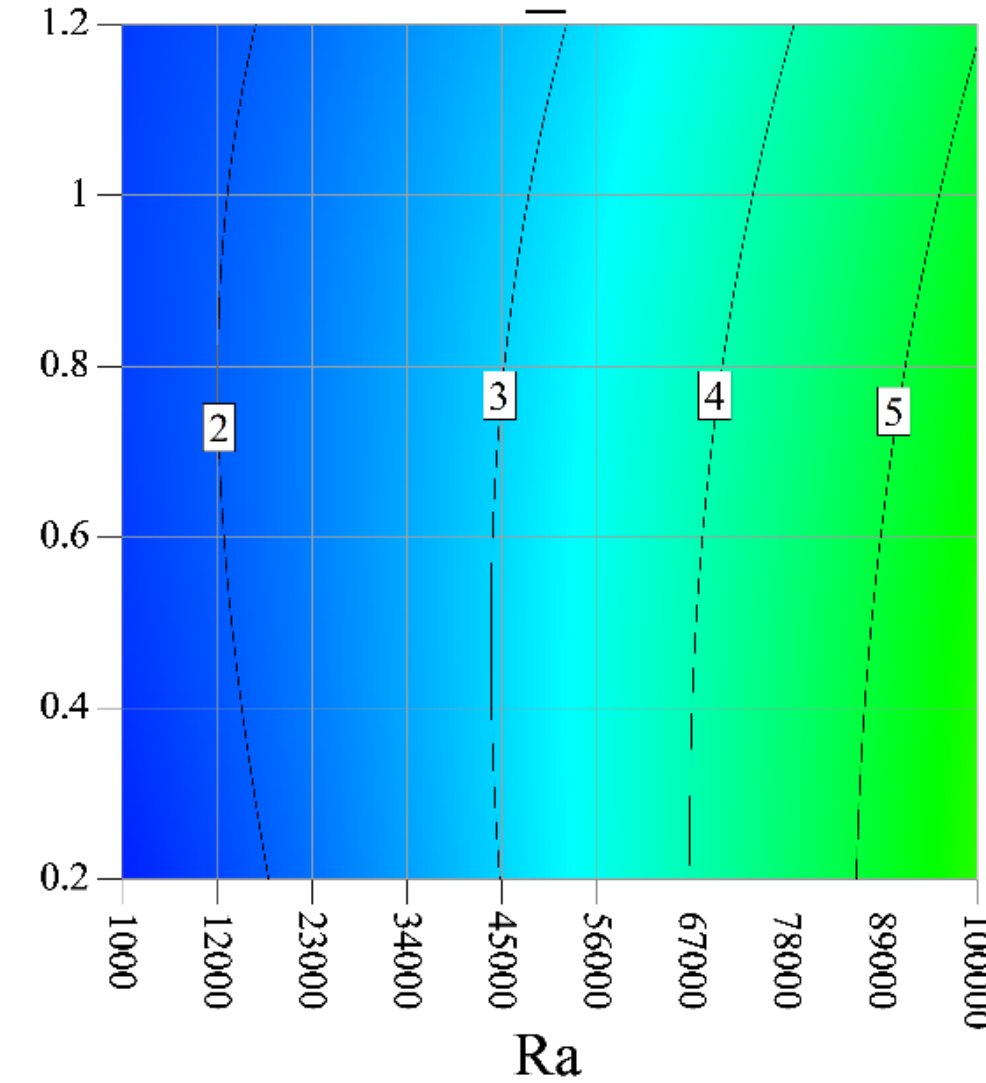
Figure 8. EGN for different Ra and various blade lengths when Ha = 30, W = 0.5, and the volume fraction is 0.3%.